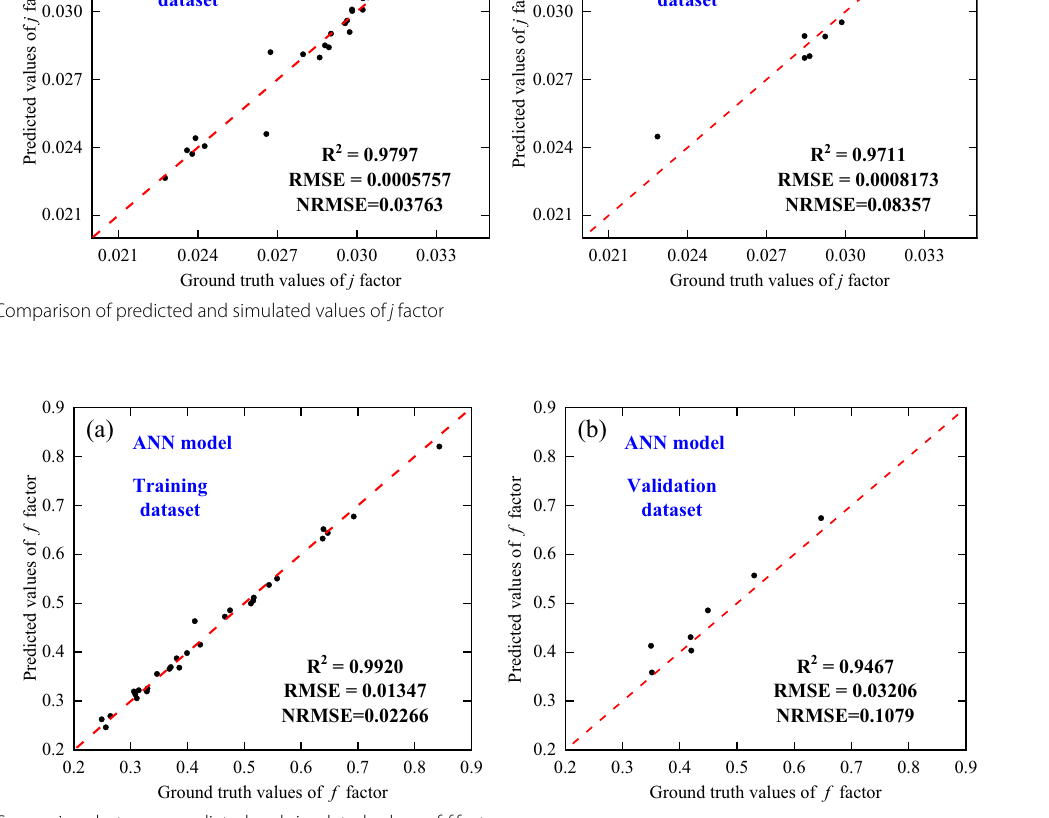
Figure 7 Comparison between predicted and simulated values of f factor